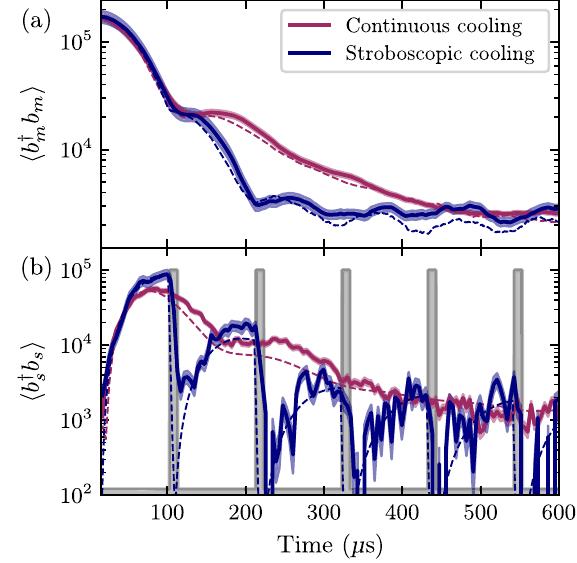
FIG. 3. (a) Membrane and (b) spin occupation numbers for ¼ 2 g and stroboscopic cooling at continuous cooling at γ s γ ¼ 0 . 6 g . The gray shaded areas indicate the spin pumping s ≈ 60 g ). Solid lines and shaded areas correspond pulses (where γ s to the mean and standard deviation of 70 measurements and dashed lines correspond to a